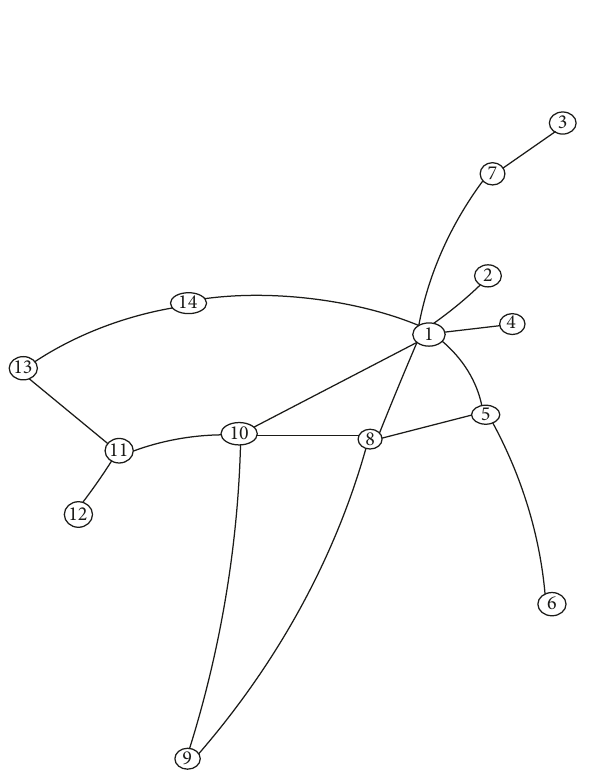
Figure 5: Physical network structure of passenger